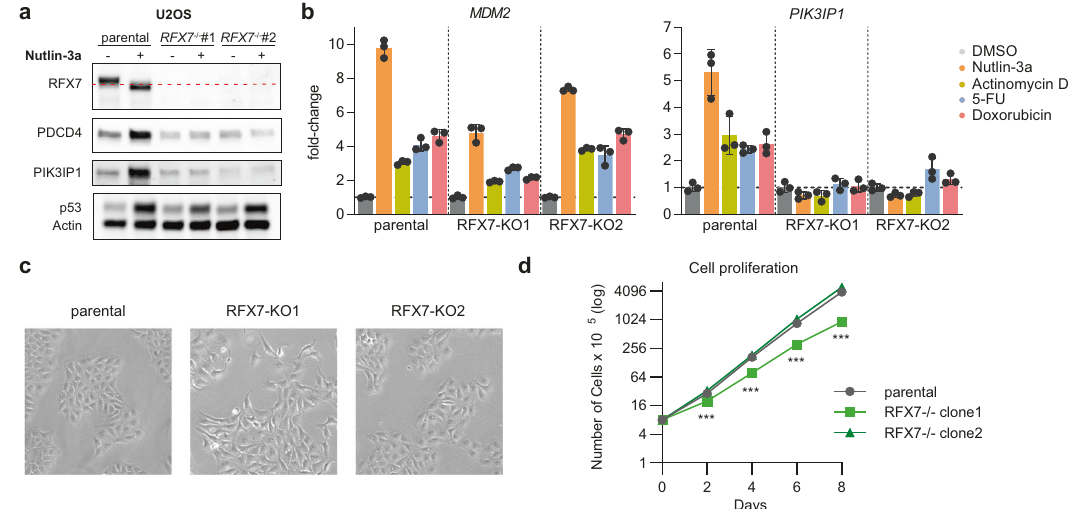
Fig. 1 Generation and validation of U2OS RFX7 knock-out cell lines. a Western blot analysis of RFX7, PDCD4, PIK3IP1, p53, and actin (loading control) levels in parental and RFX7 knock-out ( RFX7 − / − ) U2OS cells treated with Nutlin-3a or dimethyl sulfoxide (DMSO) solvent control. Uncropped western blot images available in Supplementary Fig. S1a. b RT-qPCR data of the RFX7 target PIK3IP1 in parental and RFX7 knock-out U2OS cells treated with Nutlin-3a, Actinomycin D, 5-FU, Doxorubicin, or DMSO solvent control. MDM2 served as a positive control for p53 induction. Normalized to DMSO treatment and ACTR10 negative control. Mean and standard deviation is displayed; n = 3 technical replicates. With the exception of the 5-FU treatment in RFX7-KO2 (adj. p = 0.43), all comparisons of PIK3IP1 expression between parental cells and RFX7 knock-out lines under non-DMSO treatment conditions were signi fi cant (adj. p < 0.001). Expression was not signi fi cantly different under DMSO treatment (adj. p > 0.99). All tests have been performed using a one-way ANOVA. c Bright fi eld images of parental and RFX7 knock-out U2OS cells. d Cell number of parental and RFX7 knock-out U2OS cells following indicated days of cell culture. N = 4 biological replicates per time point. Statistical signi fi cance assessed by a two-sided unpaired t -test. Statistical signi fi cance displayed for clone2 compared with parental. Clone1 compared with parental displayed no signi fi cant